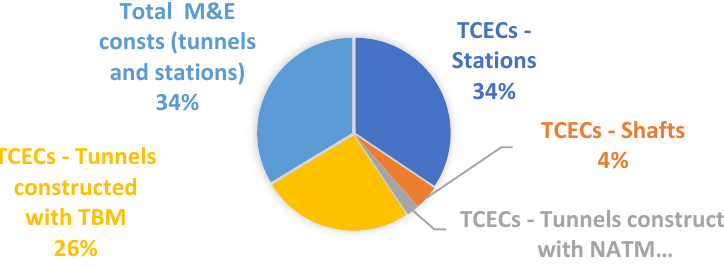
Figure 1. Cost distribution for the construction of Athens Metro Line 3 extension from Chaidari to Piraeus.